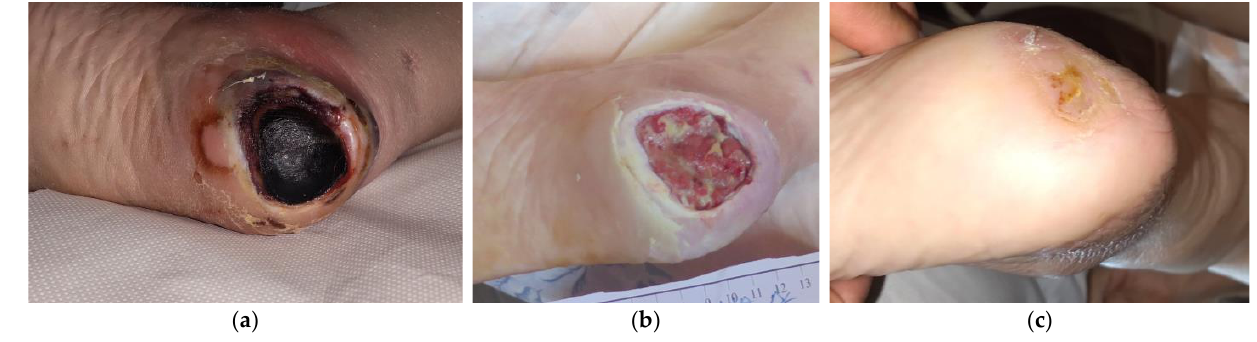
Figure 1. Case 1: ( a ) clinical findings at the initial examination, day 0 (start of MGH treatment); ( b ) effective debridement and healthy granulation tissue after four weeks of MGH therapy; ( c ) complete wound healing after 17 weeks of MGH therapy.